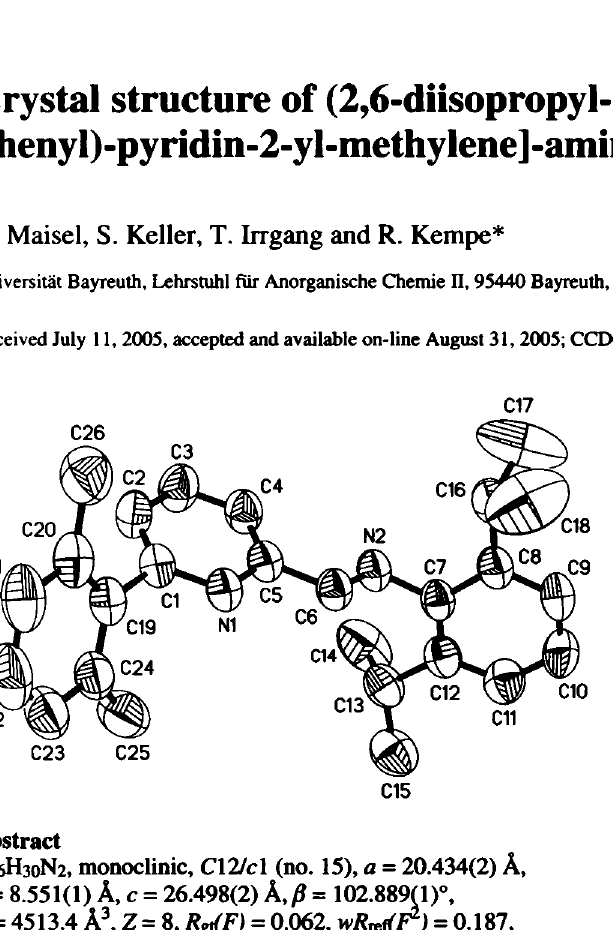
Table 1. Data collection and handling.